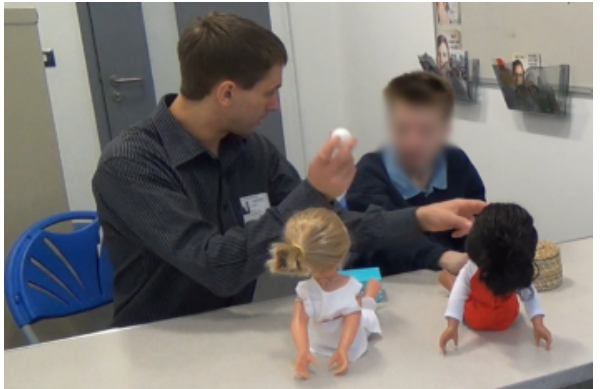
Figure 8: Child participating in the Sally-Anne test.